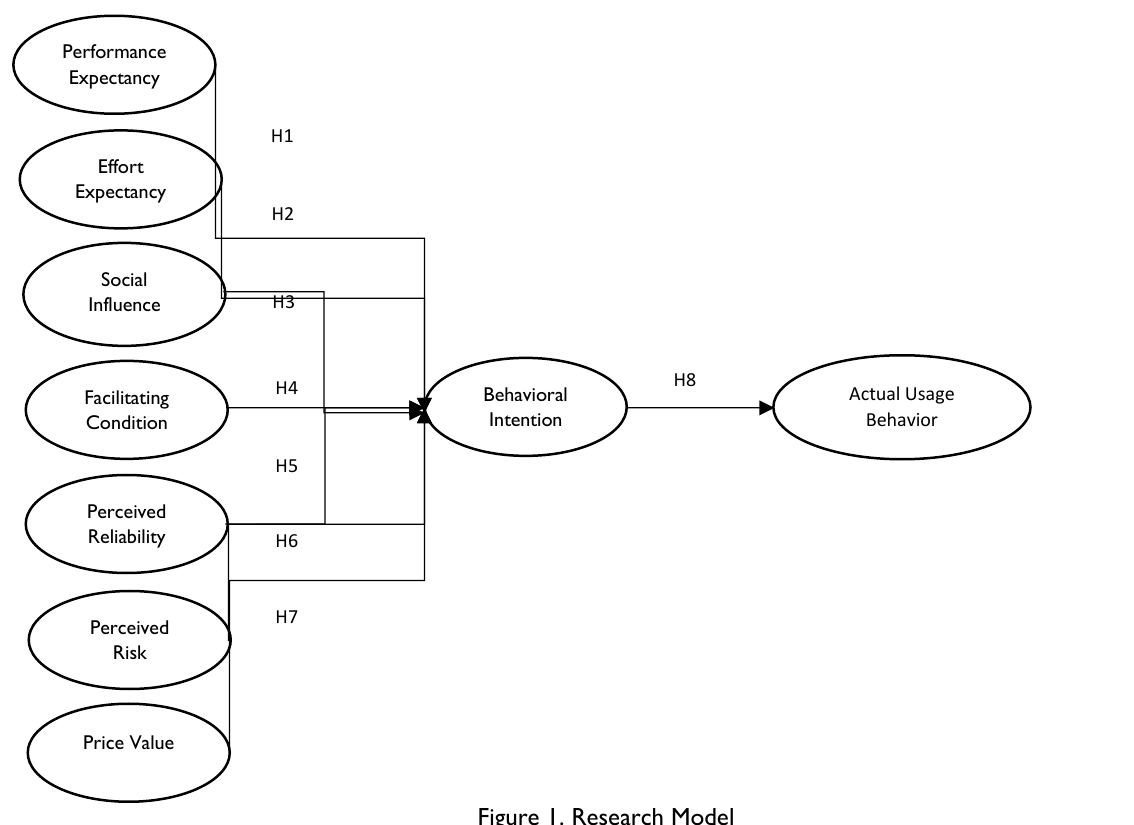
Table 1. Instrument